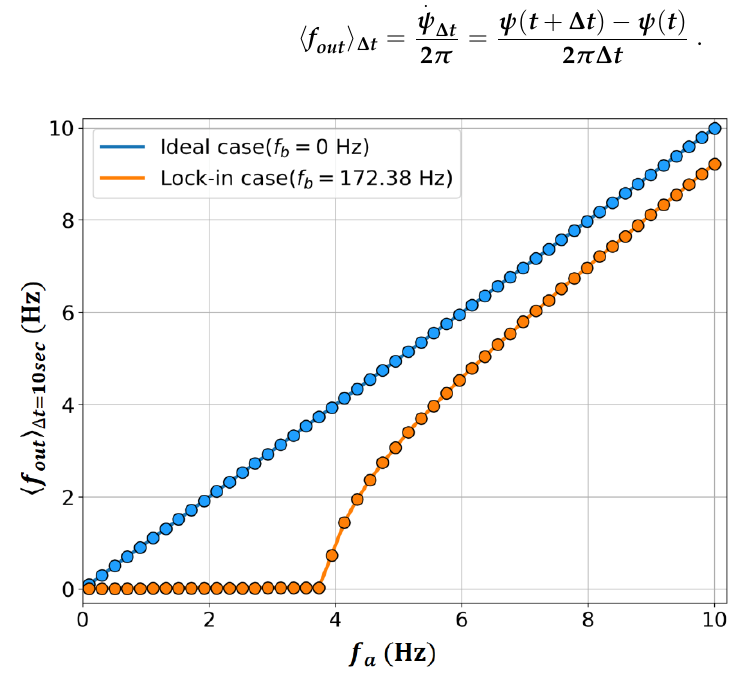
Figure 1. Numerically calculated RLG outputs 〈𝒇 𝒐𝒖𝒕 〉 ∆𝒕 with sinusoidal dithering as a function of = a / 2 π 𝒇 𝒂 = 𝒂/𝟐𝝅 . f a